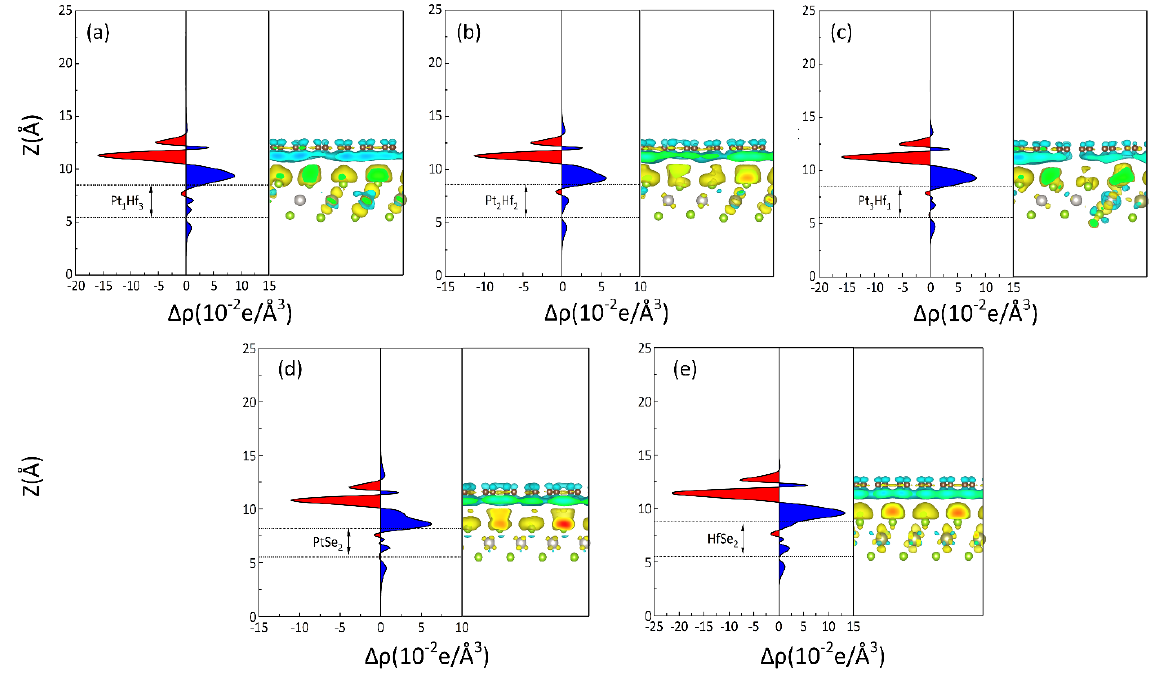
Figure 6. Charge transfer across the interface of the Gr@Pt n Hf 4 − n heterostructures. On the left is the plane-averaged charge density difference Δ ρ (z) along the z-direction for the ( a ) Gr@Pt 1 Hf 3 , ( b ) Gr@Pt 2 Hf 2 , ( c ) Gr@Pt 3 Hf 1 , ( d ) Gr@PtSe 2 , and ( e ) Gr@HfSe 2 heterostructures, respectively. The blue and red area represent charge accumulation and depletion, respectively. On the right is side views of the three-dimensional charge density difference plots for corresponding heterostructures, respectively. Yellow and green iso-surfaces represent charge accumulation and depletion in the space with respect to isolated graphene and the Pt n Hf 4 − n slab substrate.